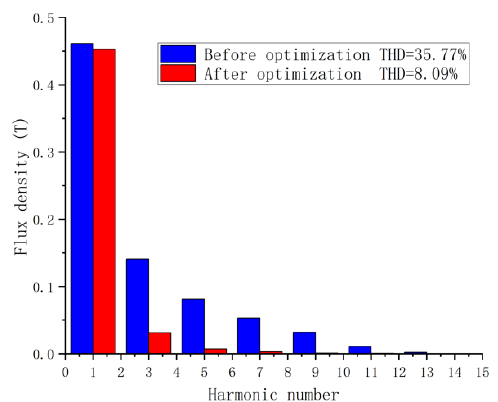
Figure 8. Comparison of harmonic components at 50 mm eccentricity.